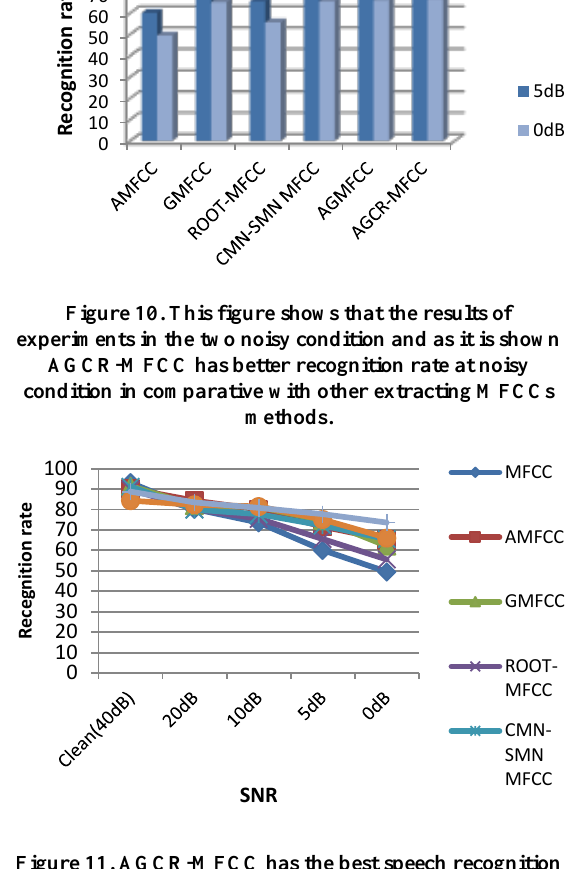
Figure 11. AGCR-MFCC has the best speech recognition especially in noisy condition such as 5dB and 0Db which the results are clearer in these SNRs.